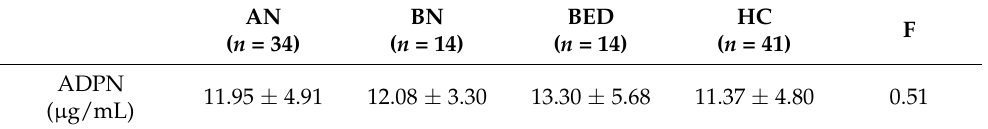
Table 2. Adiponectin (ADPN) levels in patients and healthy participants.